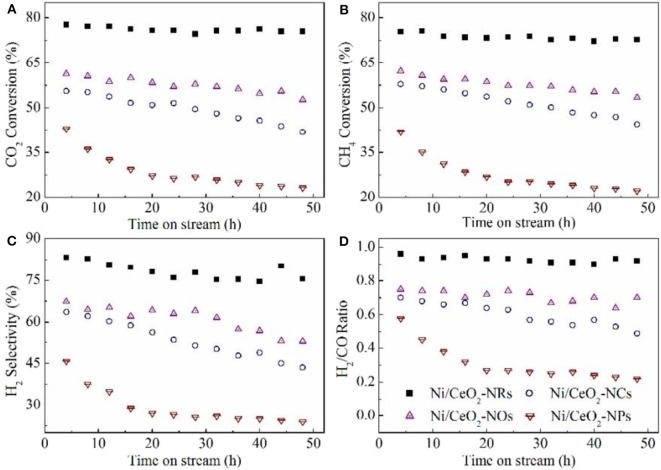
Catalytic stability test of the Ni/CeO2 samples for methane dry reforming at 700°C for 50 h. (A) CO2 conversion; (B) CH4 conversion; (C) H2 selectivity; (D) H2/CO ratio. Reproduced from Wang N. et al. (2016) with permission from Catalysis Science and Technology.